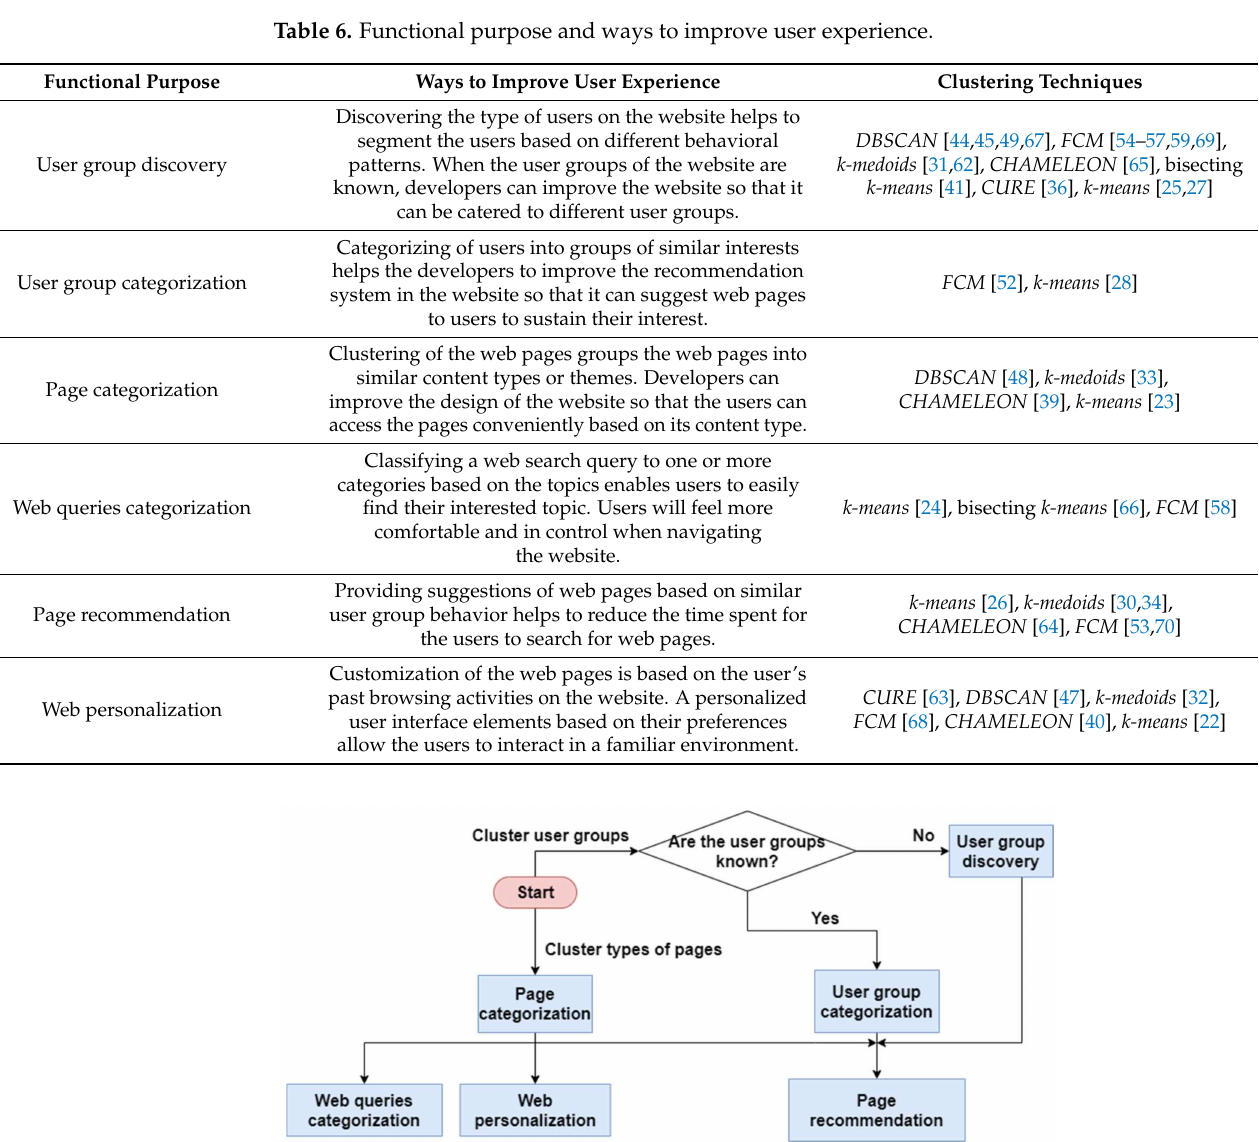
Figure 9. Relationship between the functional purposes.